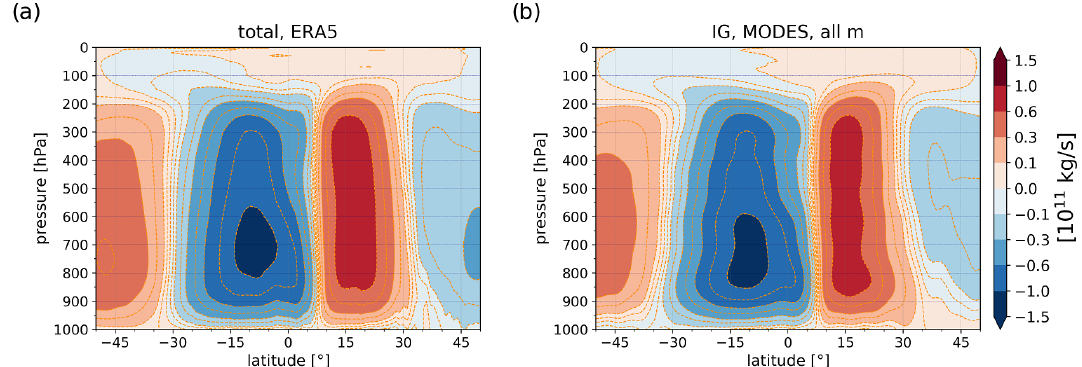
Figure A4. The 2018 mean Hadley circulation (red and blue contours) in ERA5 reanalysis computed from (a) total fields of zonal-mean meridional wind and (b) unbalanced (inertia–gravity) fields. Contours indicate values of stream function ψ